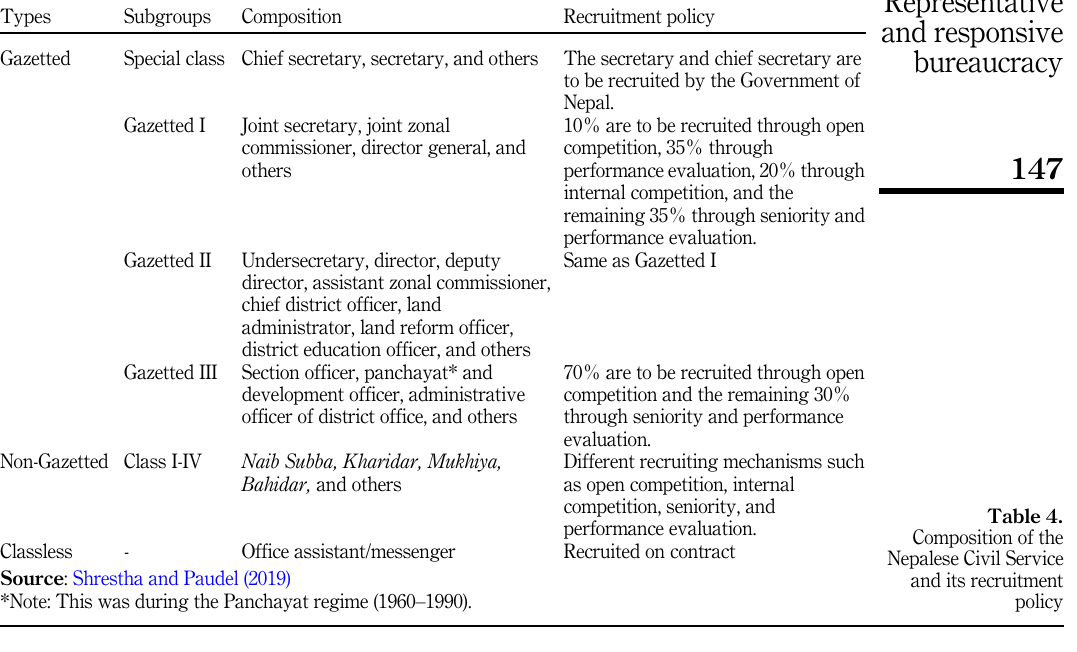
Table 4. Composition of the